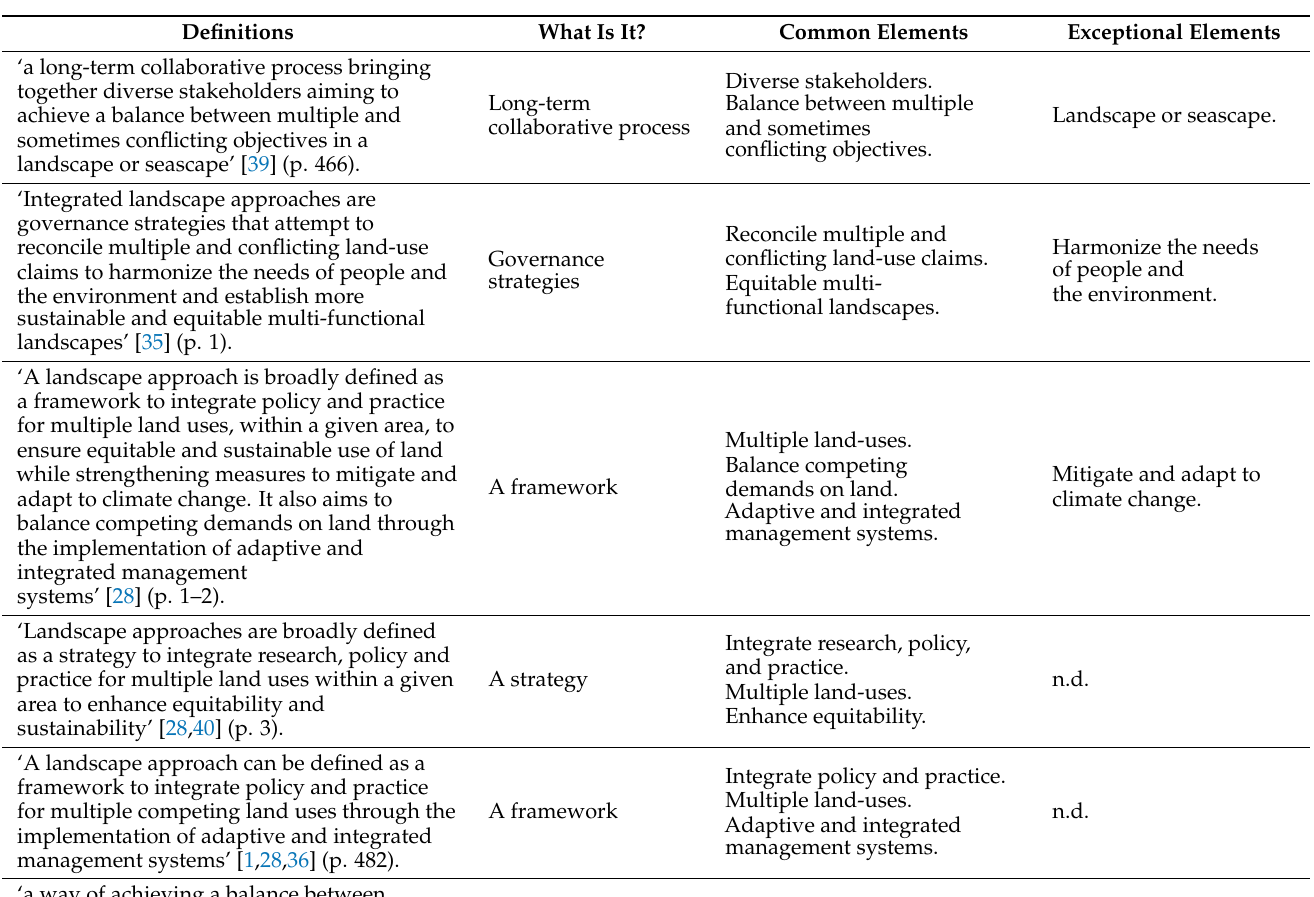
Table 1. Comparison of some definitions of Integrated Landscape